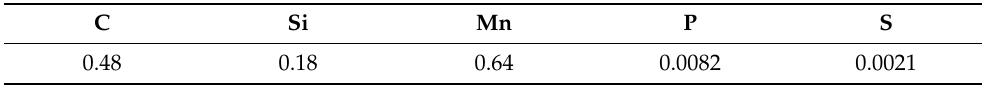
Table 1. Nominal Composition (mass percent,